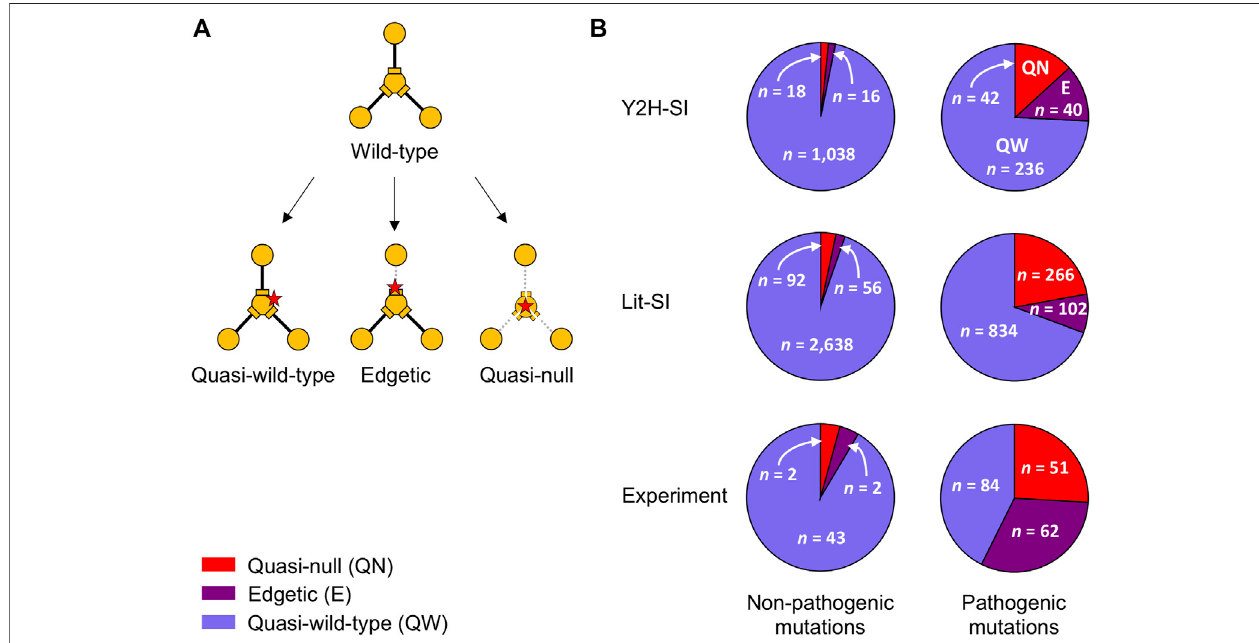
FIGURE4| Mutationedgotypesdeterminedbypredictionsandexperiments. (A) Graphicaldescriptionofquasi-wild-typemutations,edgeticmutations,andquasi- null mutations. (B) Fraction of quasi-wild-type mutations, edgetic mutations, and quasi-null mutations among common non-pathogenic mutations (left) and among pathogenic mutations (right) . Mutation edgotypes were obtained from structure-based predictions in the two human structural interactomes, Y2H-SI (top) and Lit-SI (middle) , and from experiments (bottom) . Red slices represent quasi-null mutations, purple slices represent edgetic mutations, and blue slices represent quasi- wild-type mutations.